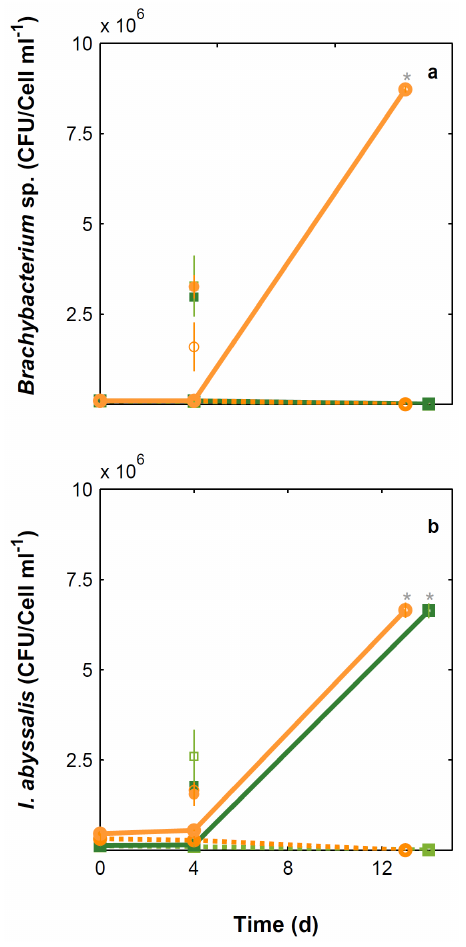
Figure 3. Brachybacterium sp. ( a ) and I. abyssalis ( b ) abundances through time. Lines refer to CFU data and isolated markers to counts obtained by means of flow cytometry. Solid lines correspond to co-cultures and dashed lines to monocultures of each bacteria isolate, under 475 (green) and 1056 µatm (orange). * Denotes significant differences.